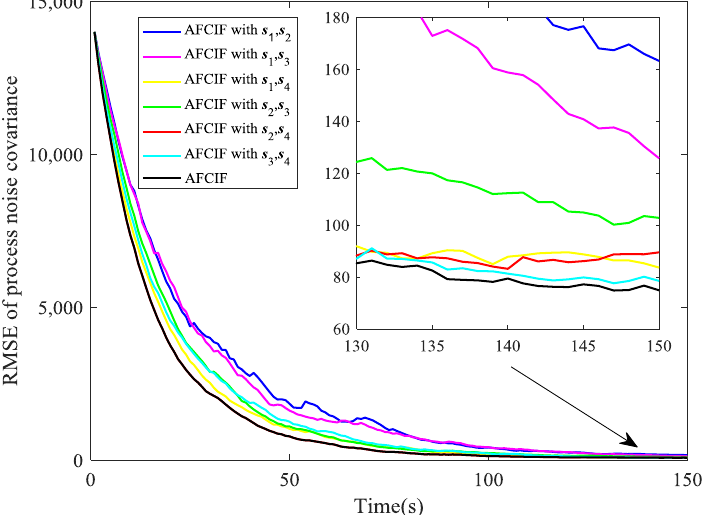
Figure 8. Comparison of RMSE (noise estimation) when the initial process noise covariance is set to be larger than the true value.